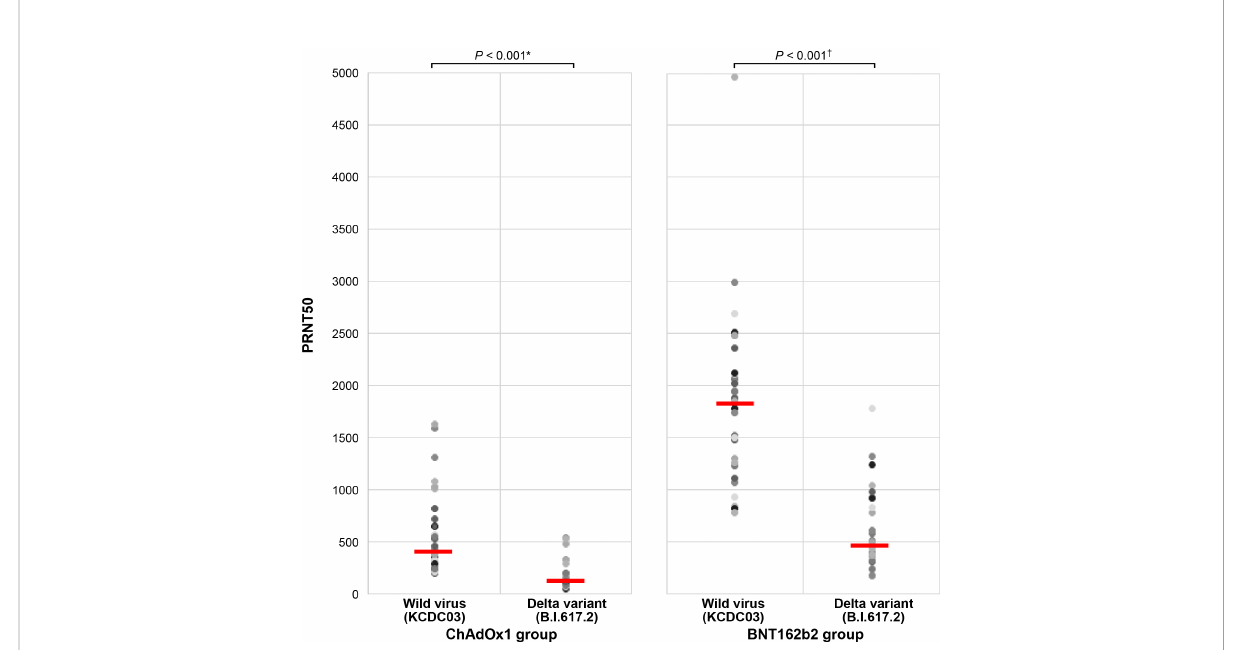
FIGURE 3 Comparison of antibody response against the wild-type and Delta variant strains between the ChAdOx1 nCoV-19 and BNT162b2 groups. *ChAdOx1 group (mean ± standard deviation): 480.1 ± 404.7 in wild-type virus and 148.3 ± 133.6 in Delta variant strain. † BNT162b2 group (mean ± standard deviation): 1706.1 ± 833.4 in wild-type virus and 487.4 ± 381.9 in Delta variant